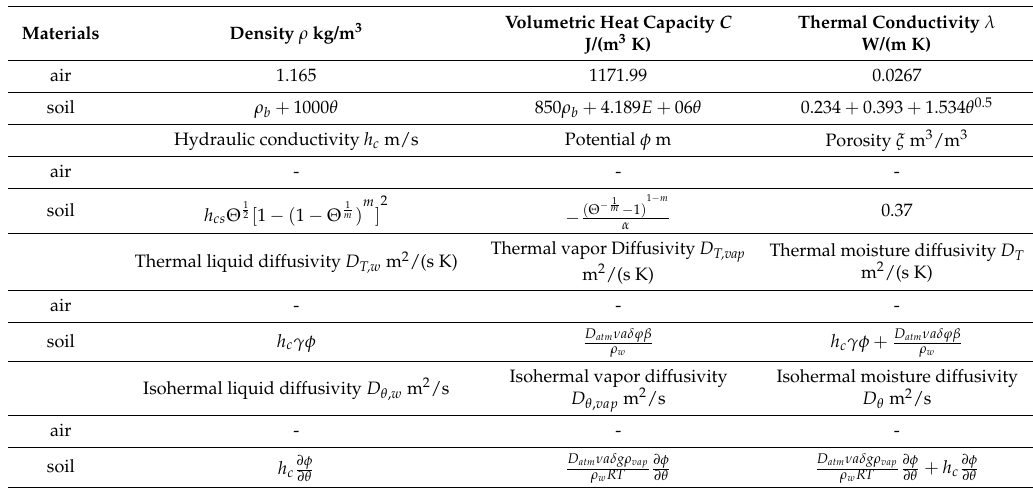
Table 1. Physical and thermal properties of medium for